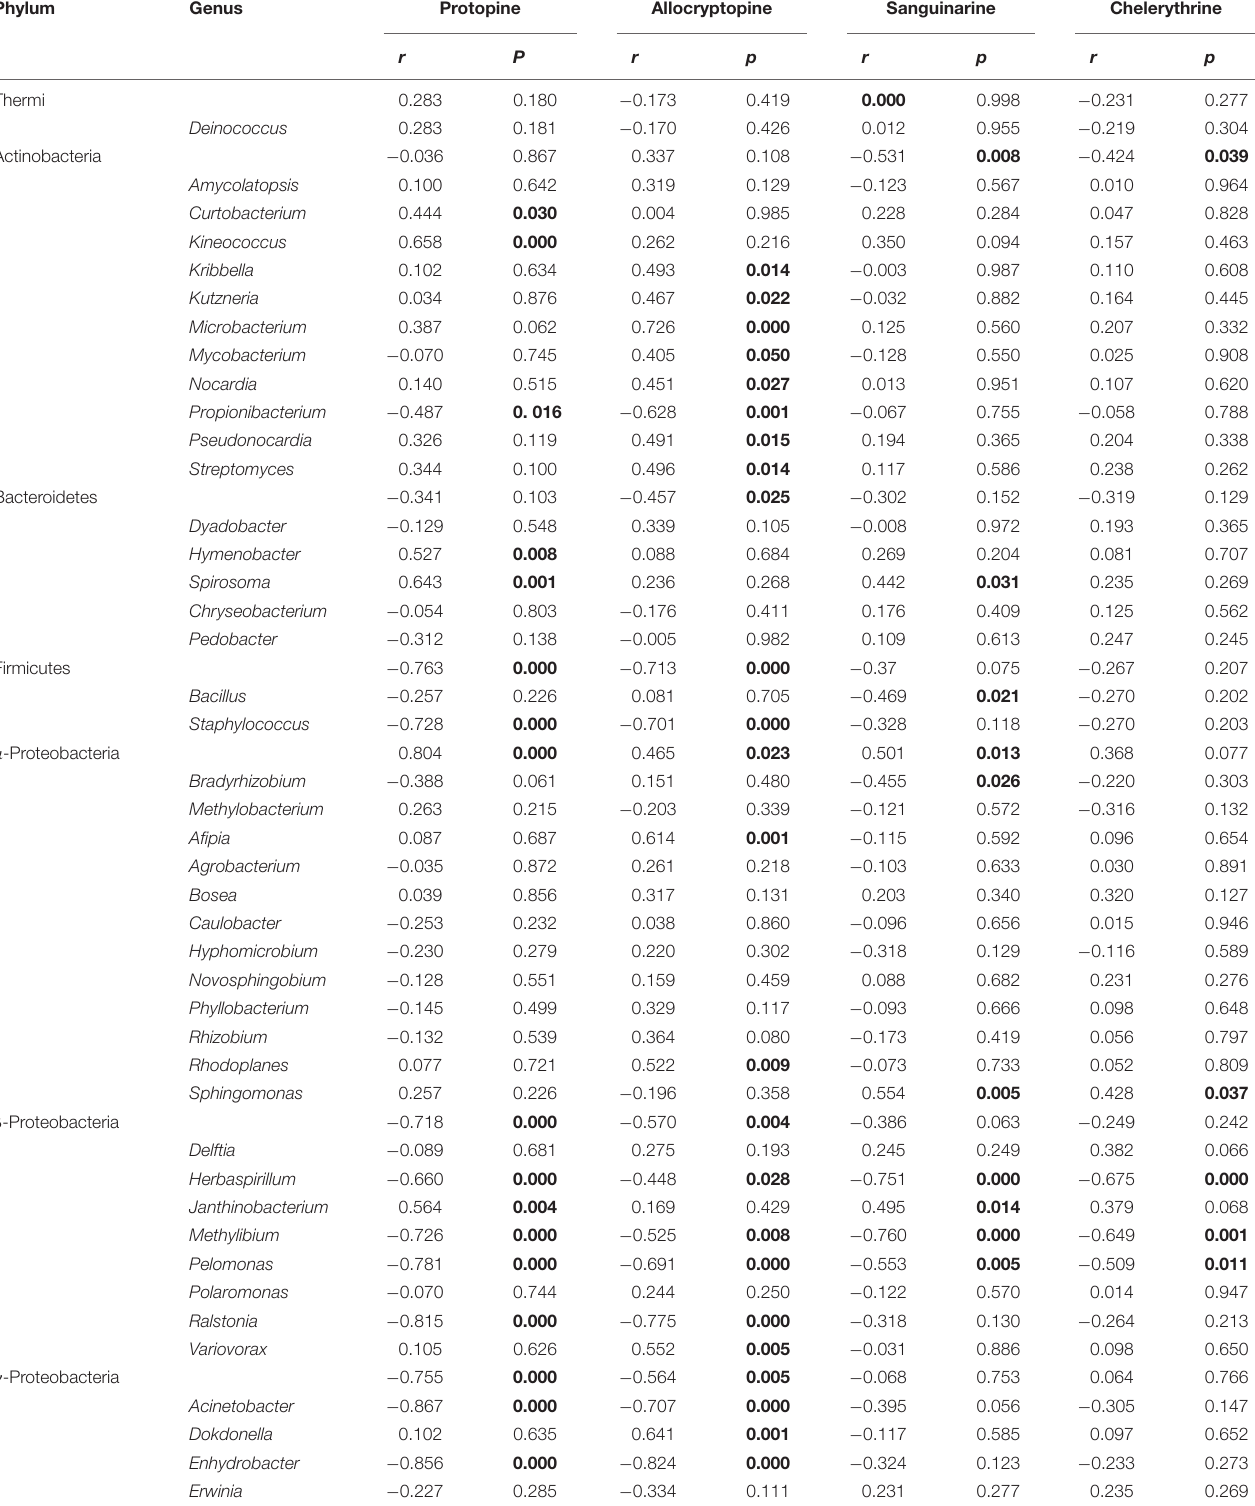
TABLE 3 | Spearman Correlation coefficients showing the relationships between endophytic bacterial genera (relative abundance > 0.01%) and four alkaloids. Phylum Genus Protopine Allocryptopine Sanguinarine